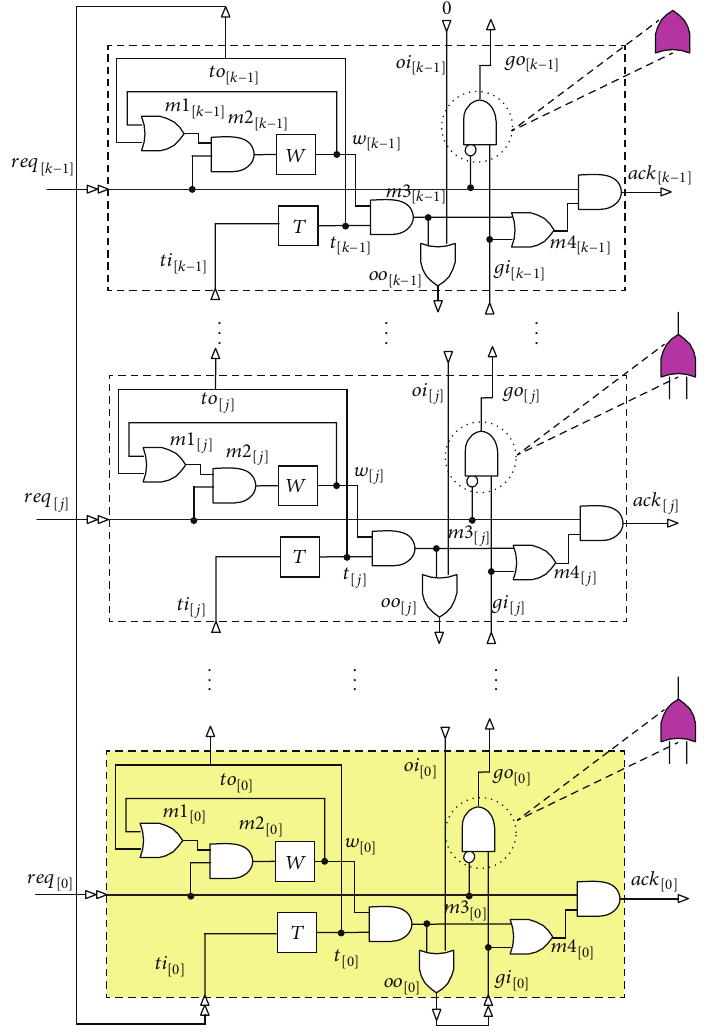
Figure 4: Chain of synchronous arbiter